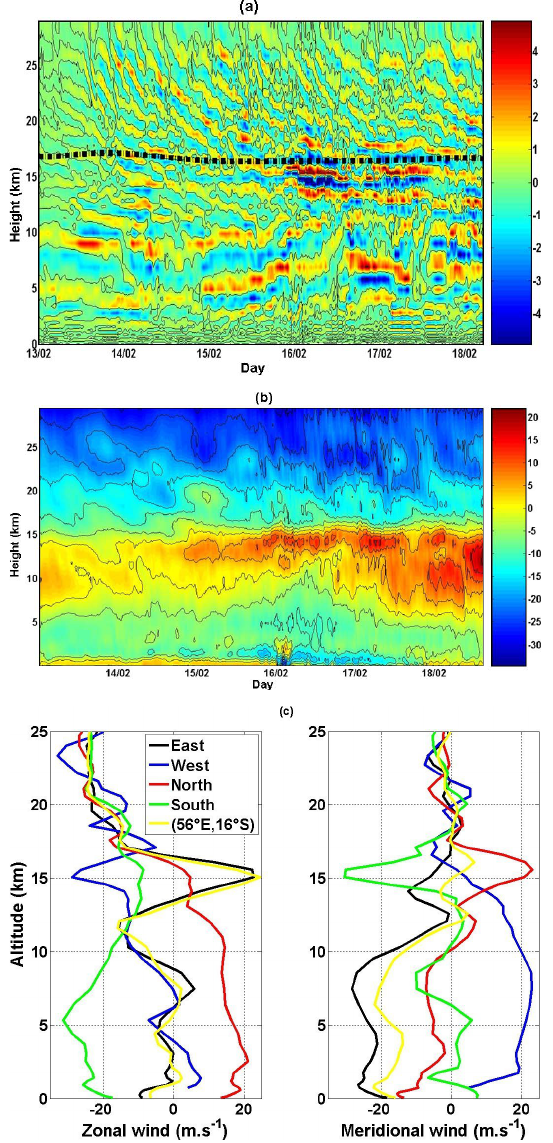
Fig. 9. (a) 10min time series of vertical profile of meridional wind perturbations (ms − 1 ) at Tromelin and (b) mean zonal wind (ms − 1 ) at Gillot from 13 February (00:00UTC) to 18 February 2008 (12:00UTC). The bold broken line shows the tropopause height. (c) Vertical profiles of zonal and meridional winds at 300km (north, east, south and west) and east at 56 ◦ E, 16 ◦ S off the TC cen- tre on 16 February at 06:00UTC.